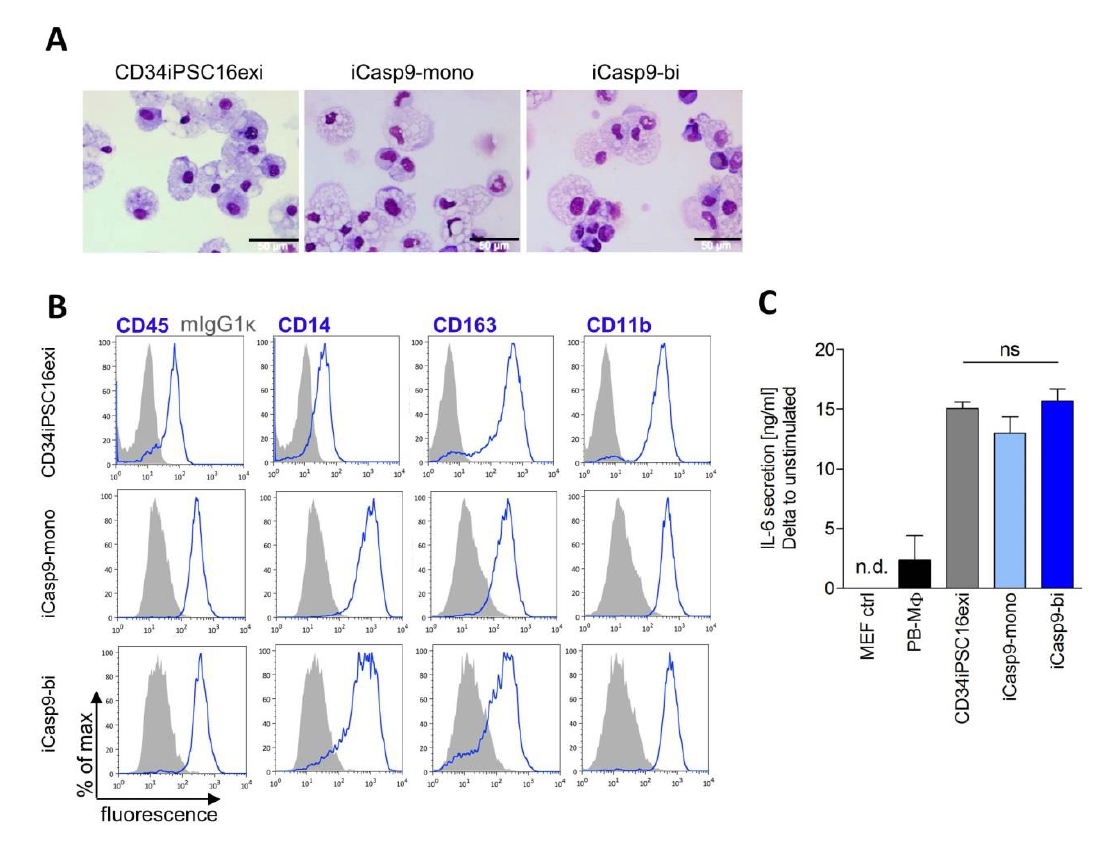
Figure 3. Characterization of the iPSC-derived MΦ. ( A ) Morphology of CD34iPSC16exi-iMΦ and iCasp9—iMΦ on May-Grünwald-Giemsa-stained cytospins (scale bar—50 µm). ( B ) Flow cytometric detection of hematopoietic (CD45) and MΦ-specific (CD14, CD163, CD11b) surface marker expression on iMΦ. ( C ) Secretion of human IL-6 upon stimulation with lipopolysaccharide (LPS). iMΦ from human iPSC lines CD34iPSC16exi (non-targeted), iCasp9-mono (clone #12) or iCasp9-bi (clone #1) were used. MEF cells served as a negative control and human PB-MΦ as a positive control (n = 2-3). n.d, not detected (<1.6 pg/mL); ns, not significant.